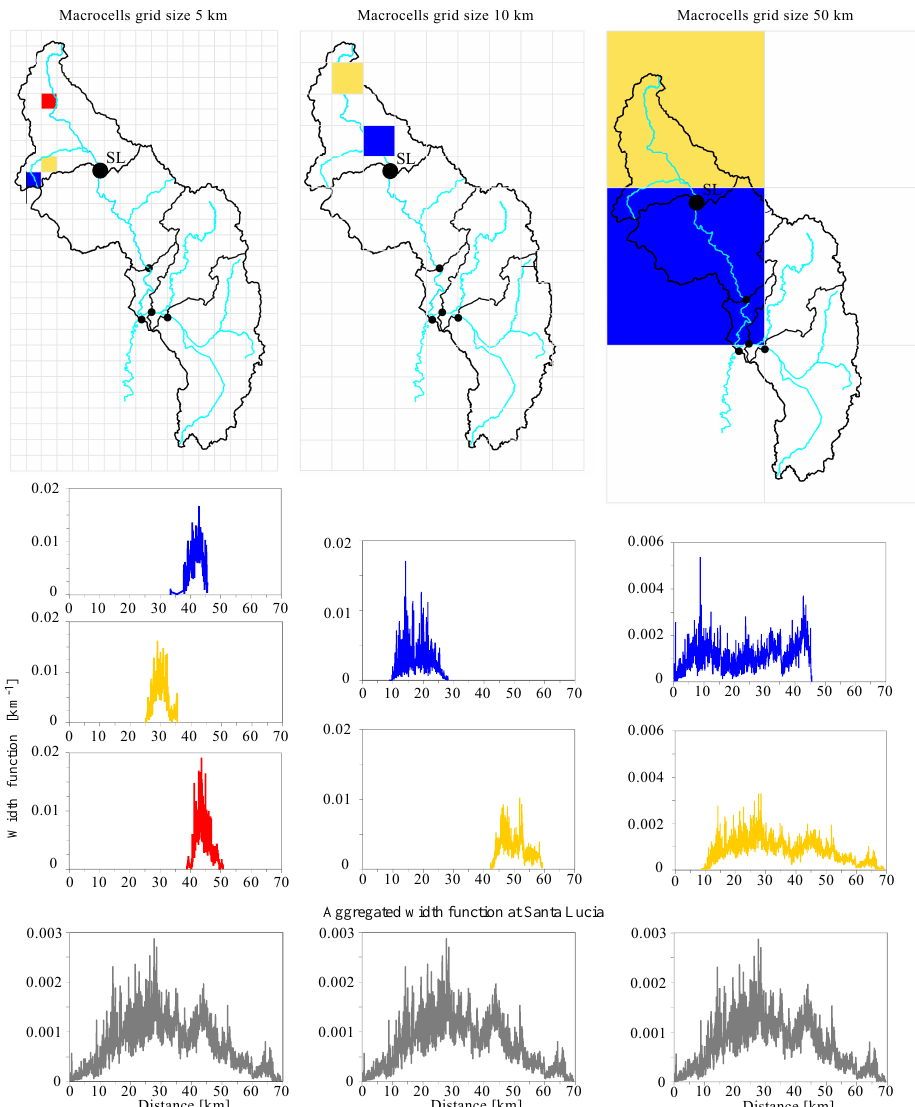
Figure 4. Width functions computed at the Santa Lucia (SL) control section for selected macrocells (colored lines) and for the whole sub- catchment (grey lines, panels at the bottom), considering grid sizes of 5, 10 and 50km. The width function of the whole sub-catchment is by design the same for the three spatial